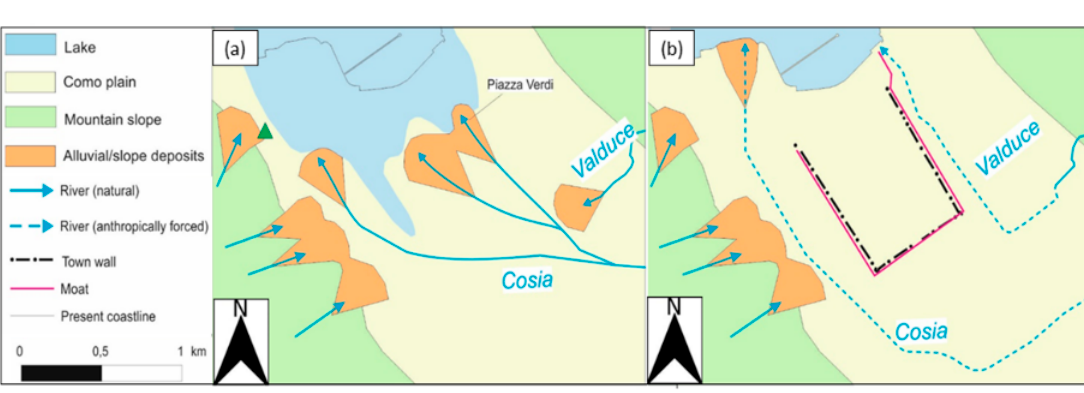
Figure 7. Landscape and settlement evolution in the Como urban area: ( a ) before the town was founded (ca. I century BC); ( b ) present day. Note the variation in the coastline position and Cosia and Valduce courses (modified from [43,59]).